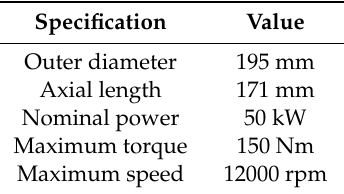
Figure 9. FE mesh of IMP SM machine. Table 2. Motor